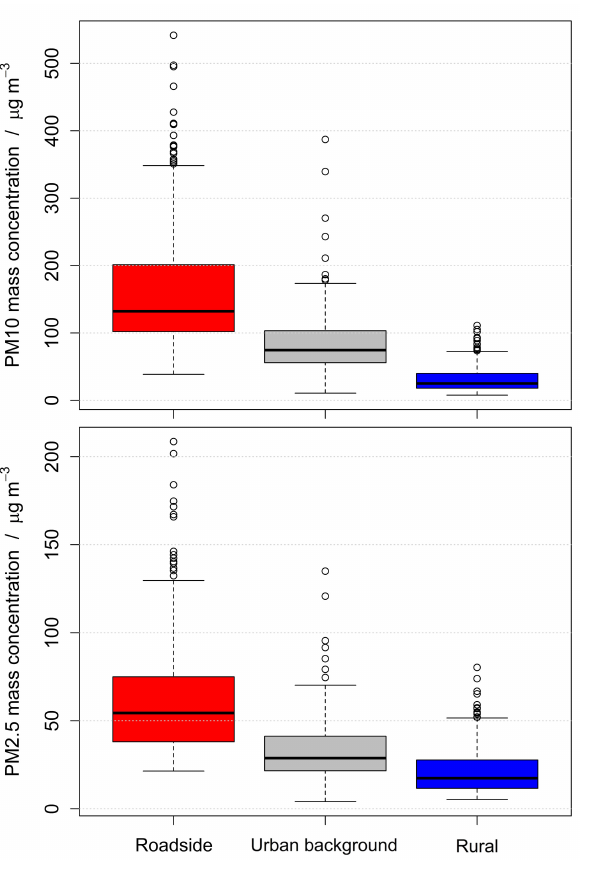
Figure 3. Box and whisker plots of the hourly averaged PM 2 . 5 and PM 10 mass concentrations measured at the three